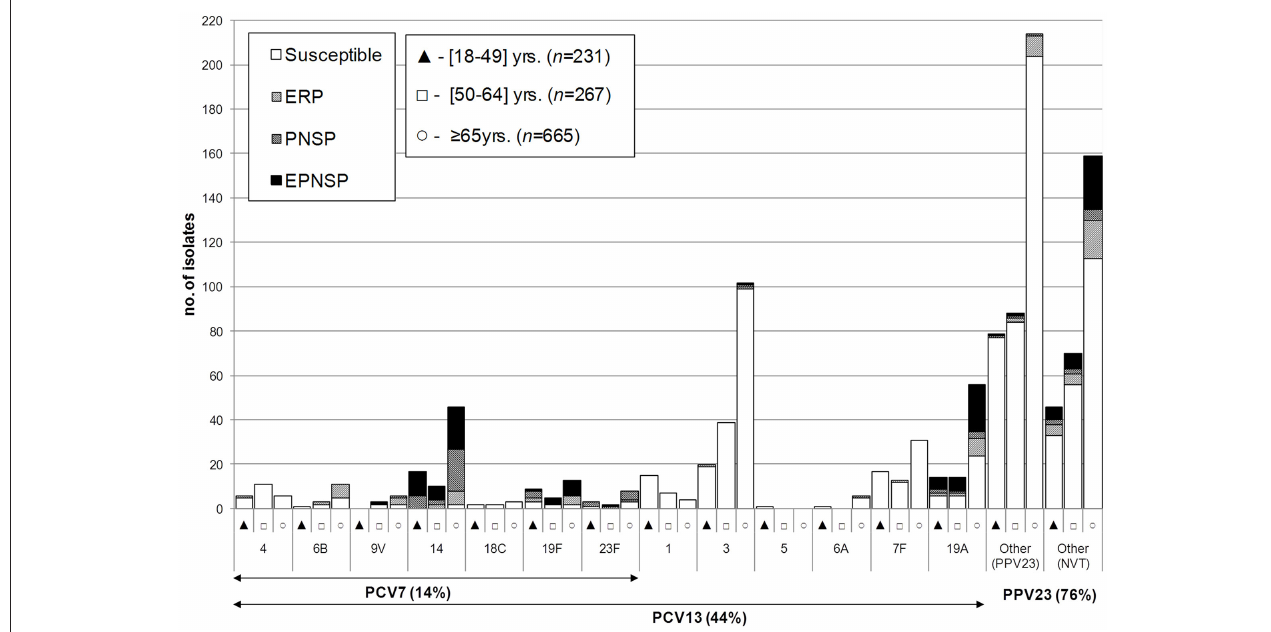
FIGURE 1 | Serotypes of isolates causing invasive pneumococcal disease in adult patients ( ≥ 18 years) in Portugal, 2012–2014. The number of isolates expressing each serotype in each of the age groups considered is indicated. Isolates recovered from patients 18–49 years are indicated by black triangles, from patients 50–64 years by open squares, and from patients ≥ 65 years by open circles. Isolates presenting both erythromycin resistance and penicillin non-susceptibility (EPNSP) are represented by black bars. Penicillin non-susceptible isolates (PNSP) are indicated by dark hatched bars. Erythromycin resistant pneumococci (ERP) are indicated by light hatched bars. Isolates susceptible to both penicillin and erythromycin are represented by white bars. The serotypes included in the seven-valent conjugate vaccine (PCV7) and in the 13-valent conjugate vaccine (PCV13) are indicated by the arrows. NVT, non-vaccine serotypes; PPV23, 23-valent polysaccharide